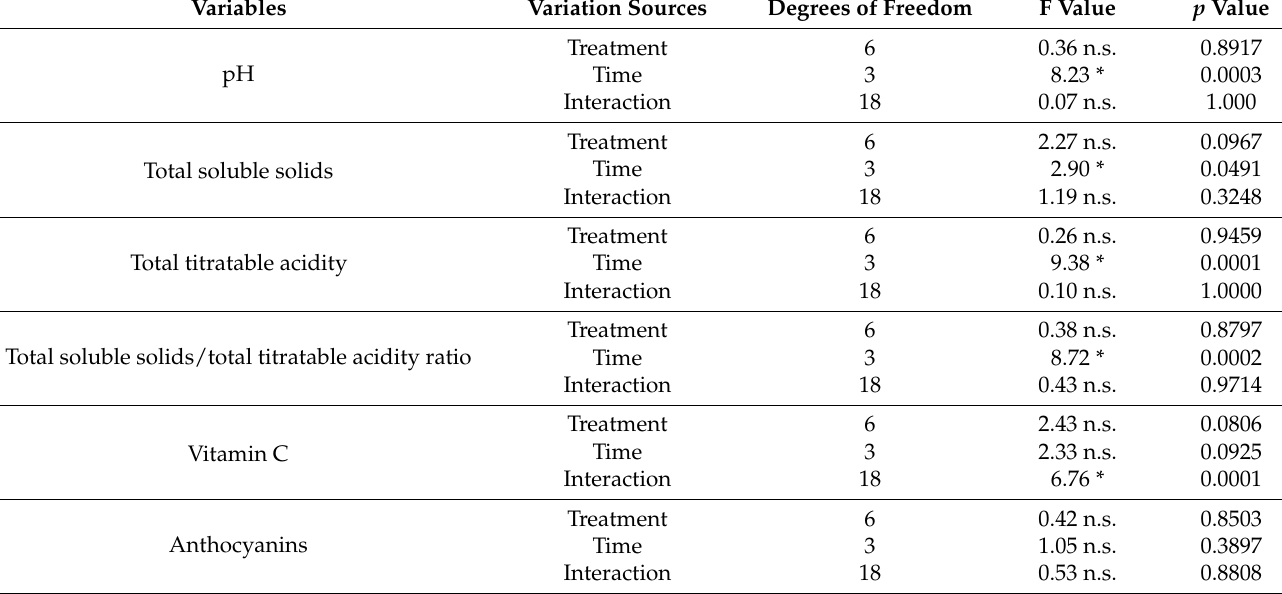
Table 1. Analysis of variance (ANOVA) for pH, total soluble solids, total titratable acidity, total soluble solids/total titratable acidity ratio, vitamin C and anthocyanins in sanitized strawberries in storage for 9 days at 6 ± 1 ◦ C.